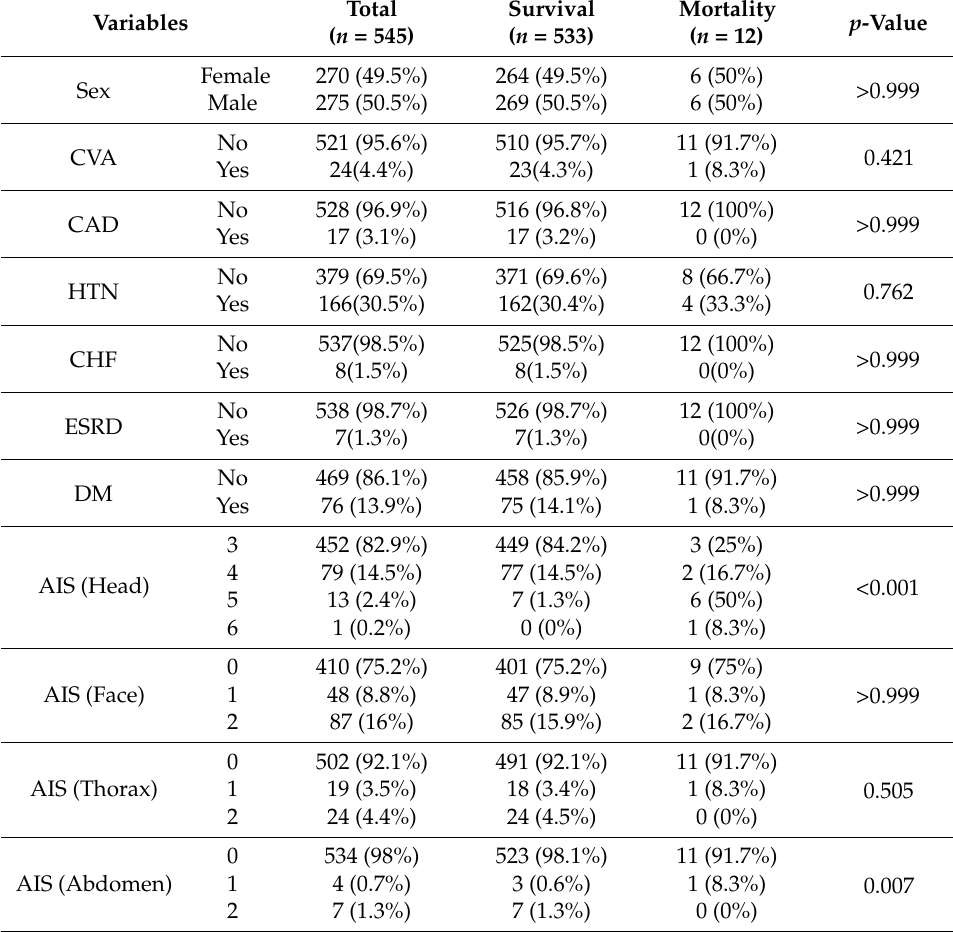
Table 1. Categorical variables of patient sex, co-morbidities, and abbreviation injury scale (AIS) scores in the body regions. CVA: cerebral vascular accident; CAD: coronary artery disease; HTN: hypertension; CHF: congestive heart failure; ESRD: end-stage renal disease DM: diabetes